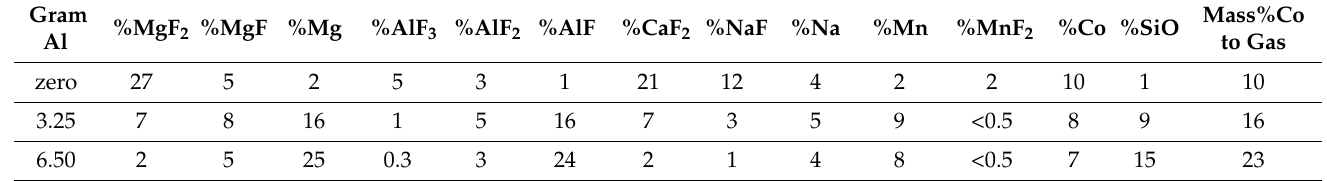
Table 7. Gas composition output from gas–slag–metal powder equilibrium at 2500 ◦ C, calculated in FactSage 7.3 Equilib module